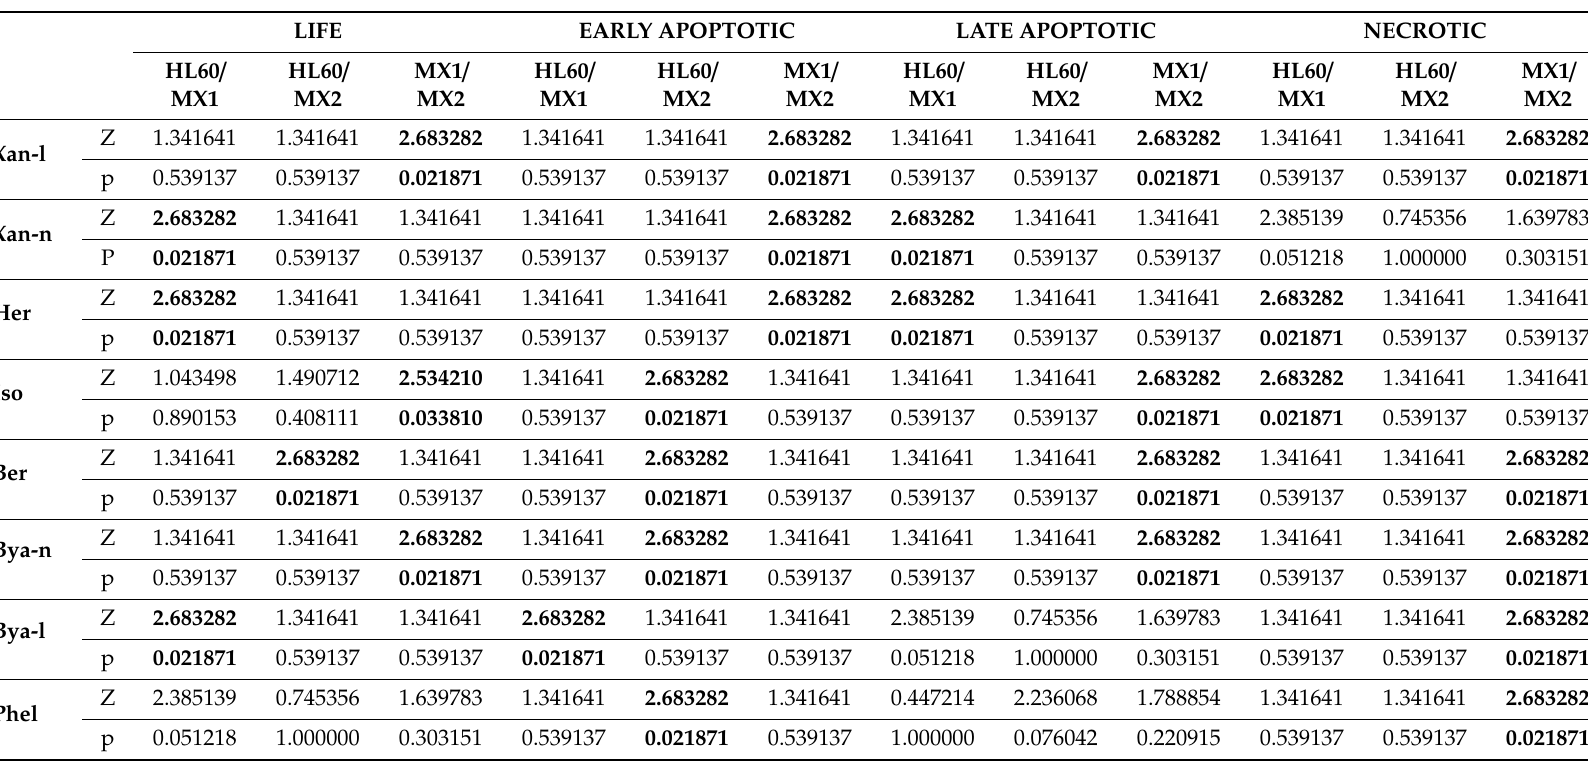
Table 1. Statistically significant di ff erences between the lines exposed to the tested furanocoumarin without the presence of mitoxantrone. Results of Kruskal–Wallis test: “Z” values for multiple comparisons, “ p ” values for multiple comparisons. The level of statistical significance was set at p <